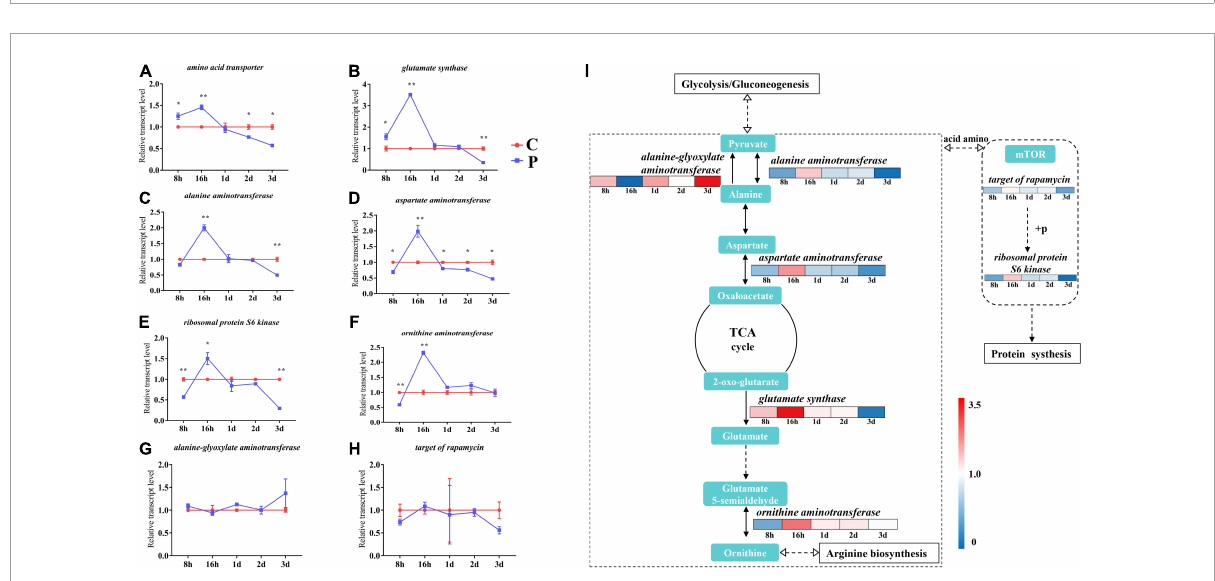
FIGURE6 Changes in expression of amino acid metabolism genes in cotton aphid. Line chart (A–B) and signaling pathway (I) display of gene expression. C, Non-parasitized cotton aphids; P, Parasitized cotton aphids. The fold change in gene expression in the pathway is represented by the color scale, red indicates up-regulation and blue indicates down-regulation. Statistical significance (Student’s t -test): * P < 0.05; ** P < 0.01; *** P <